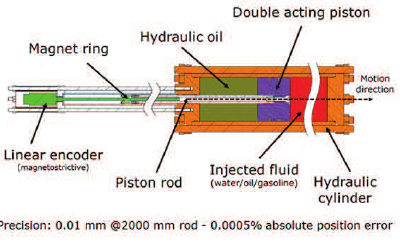
Fig. 7. PAMAR-4 fuel consumption measurement module Driver Module, ignition is set by NI 9403 TTL Digital Input/Output